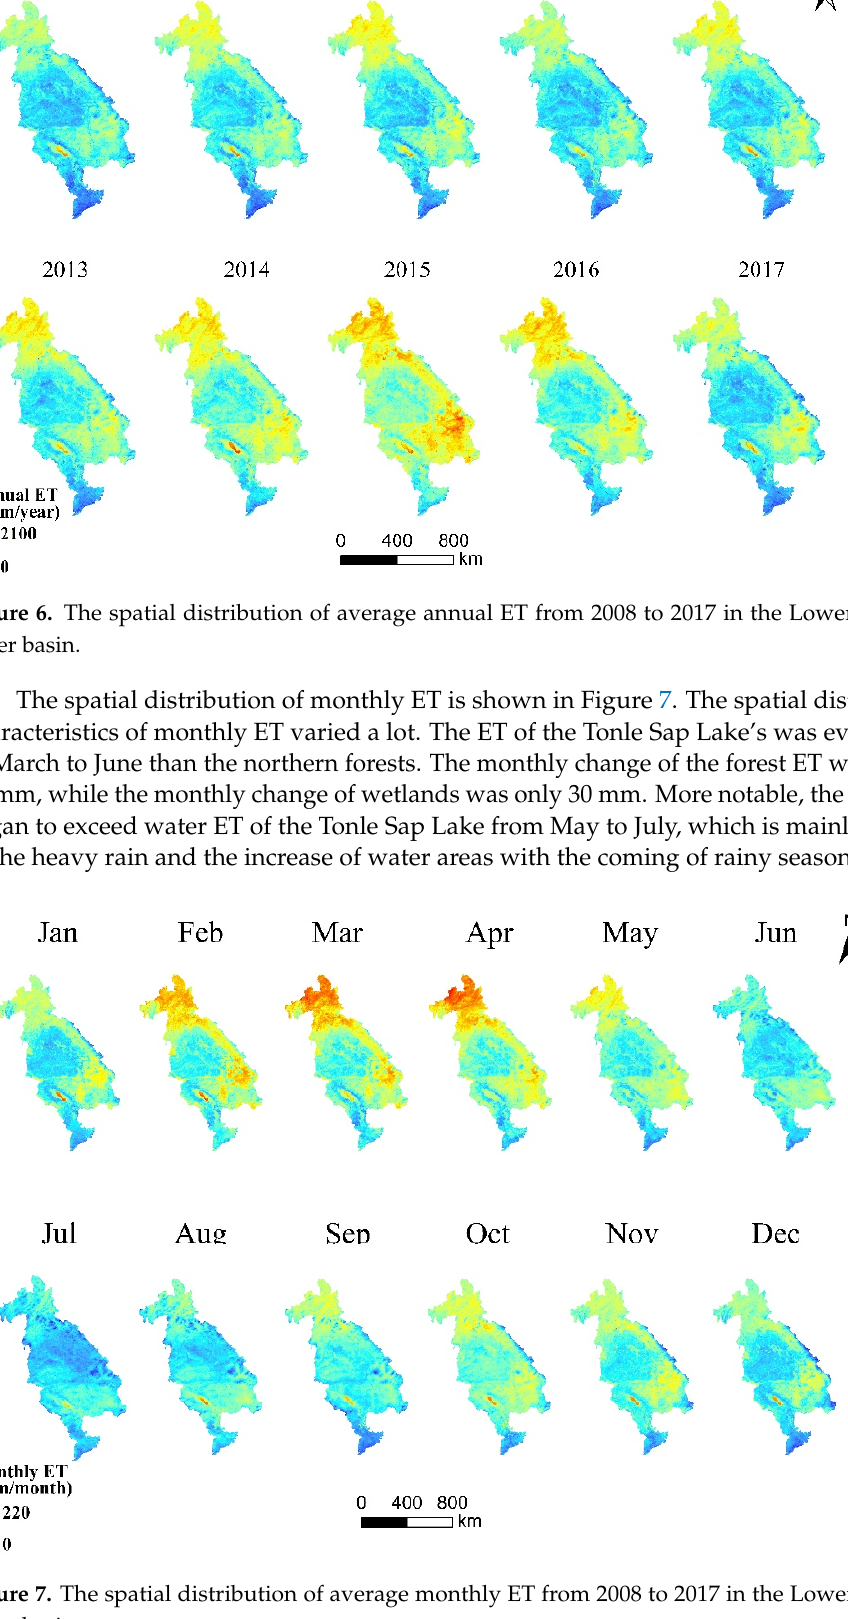
Figure 7. The spatial distribution of average monthly ET from 2008 to 2017 in the Lower Mekong River basin.